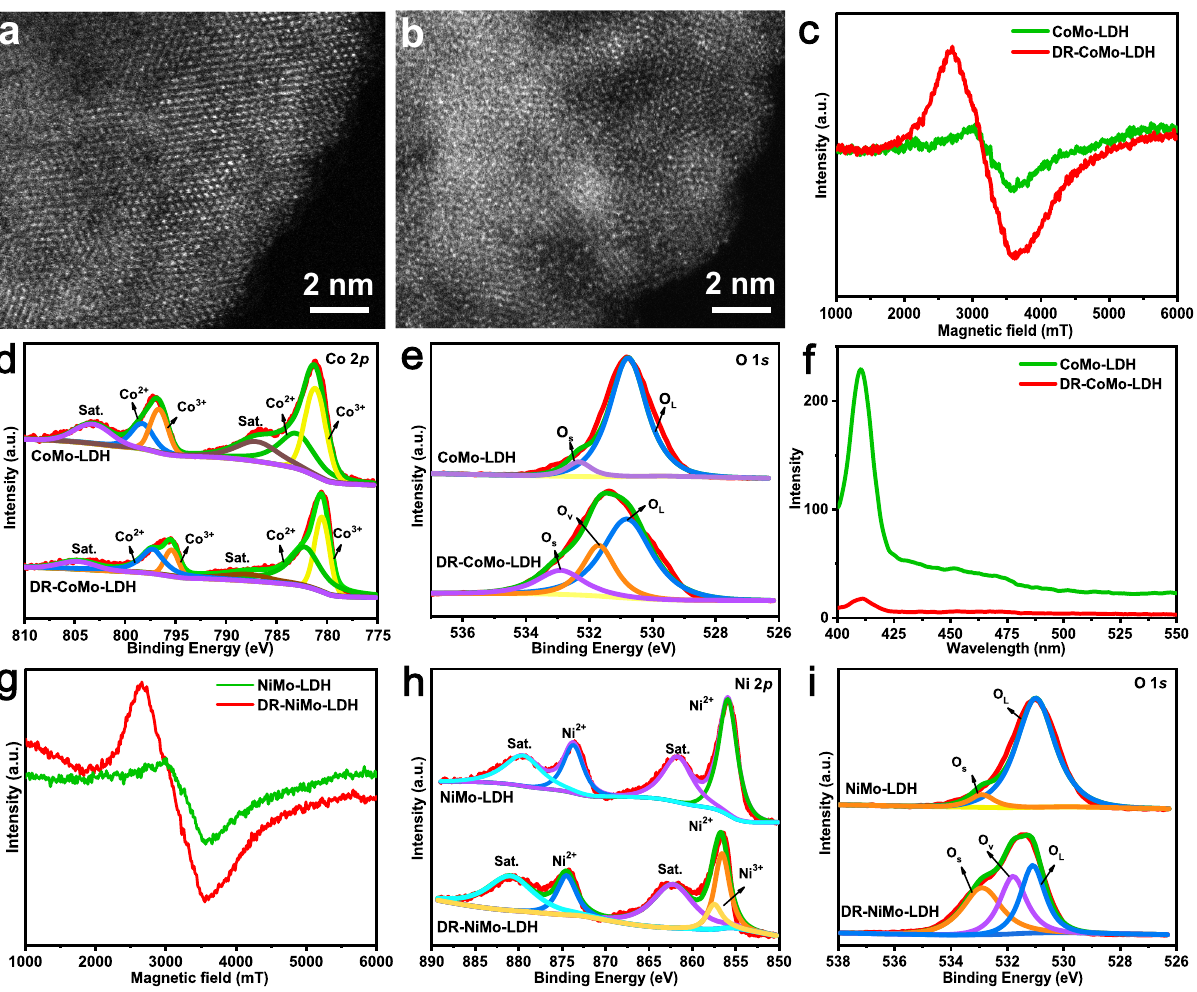
Fig. 4 Fine-structure characterizations of CoMo-LDH and DR-CoMo-LDH nanosheets. Atomic-resolution STEM images of a typical a CoMo-LDH and b DR-CoMo-LDH nanosheet. Each experiment was repeated three times with similar results. c ESR spectra of the CoMo-LDH and DR-CoMo-LDH nanosheets. d Co 2 p and e O 1 s XPS spectra of CoMo-LDH and DR-CoMo-LDH nanosheets. f PL emission spectra of CoMo-LDH and DR-CoMo-LDH nanosheets. g ESR spectra of NiMo-LDH and DR-NiMo-LDH nanosheets. h Ni 2 p and i O 1 s XPS spectra of NiMo-LDH and DR-NiMo-LDH nanosheets. Source data are provided as a Source Data fi